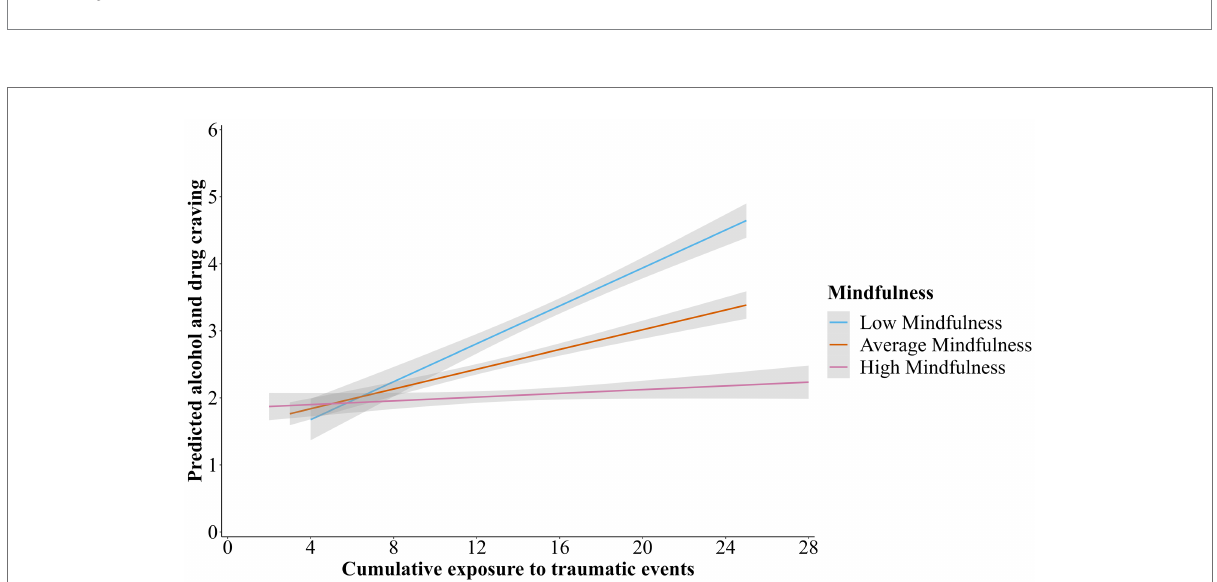
FIGURE 3 Results for moderating effects of mindfulness disposition on the associations between cumulative exposure to traumatic events, emotion dysregulation, and craving. * p < 0.05; NS = non-significant; X = predictor; M = mediator; Y = outcome; W = Moderator; Model controlled for race- ethnicity.